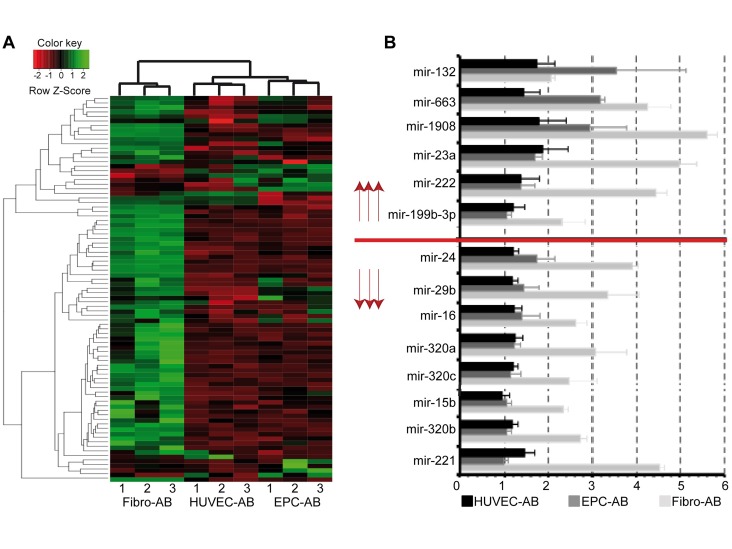
Analysis of angiogenic potential of the apoptotic bodiesFurther, cluster analysis of miRNAs differently expressed between Fibro-AB, HUVEC-AB, and EPC-AB, respectively was performed (A). Only miRNAs with a fold change of more than 2 between one of the groups with a p-value smaller than 0.05 were selected. Cluster analysis was performed using the eBayes-implementation in the R-package limma (v2.12). Specific colours indicate the row Z-score as indicated in the colour key. We analyzed the expression of angiogenesis related miRNAs (B). Shown is the signal intensity compared with total RNA as log2 of the mean with the S.D. of each three independent array experiments in HUVEC-AB (black bars), EPC-AB (grey bars) and Fibro-AB (hell bars).